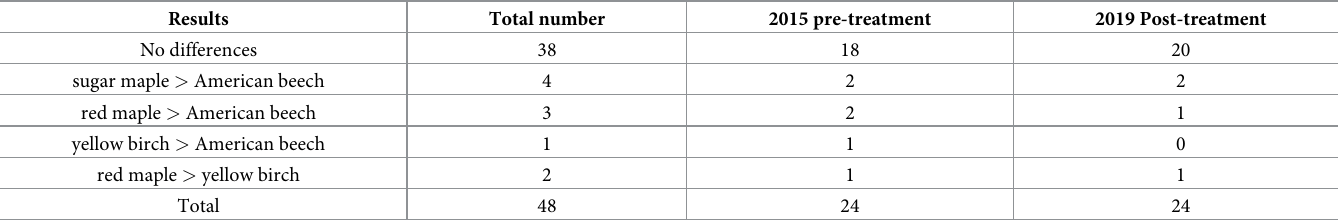
Table 6. Total numbers of significant ( P < 0.05) pair-wise comparisons for pre-treatment (2015) and post-treatment (2019) tree canopy damage